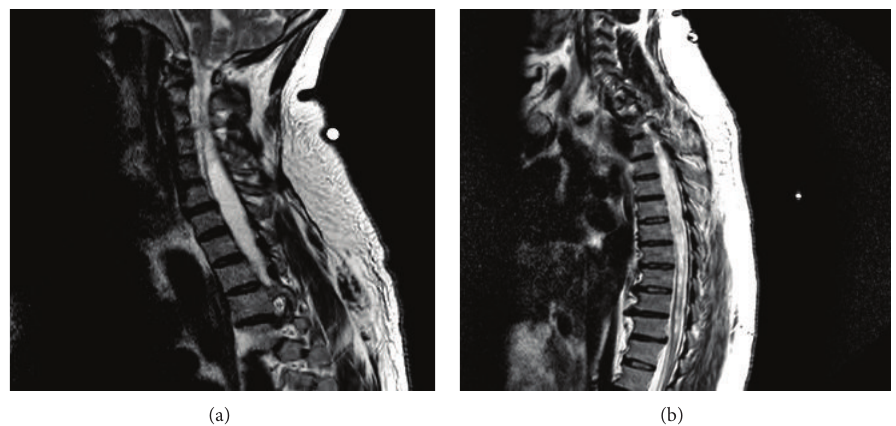
Figure 3: (a) MRI of the cervical spine showing a 9mm inferior herniation of the cerebellar tonsils through the foramen magnum (Type I Chiari Malformation), with extensive cervical and superior thoracic spinal cord syringohydromyelia. (b) Thoracic spine MRI revealing extensivesyringohydromyeliainvolvingtheentirethoracicspinalcord.Thesyringohydromyeliaismoreprominentinthesuperiormidportion of thoracic spinal cord. T11-T12 central disk protrusion with thecal sac compression and slight ventral spinal cord